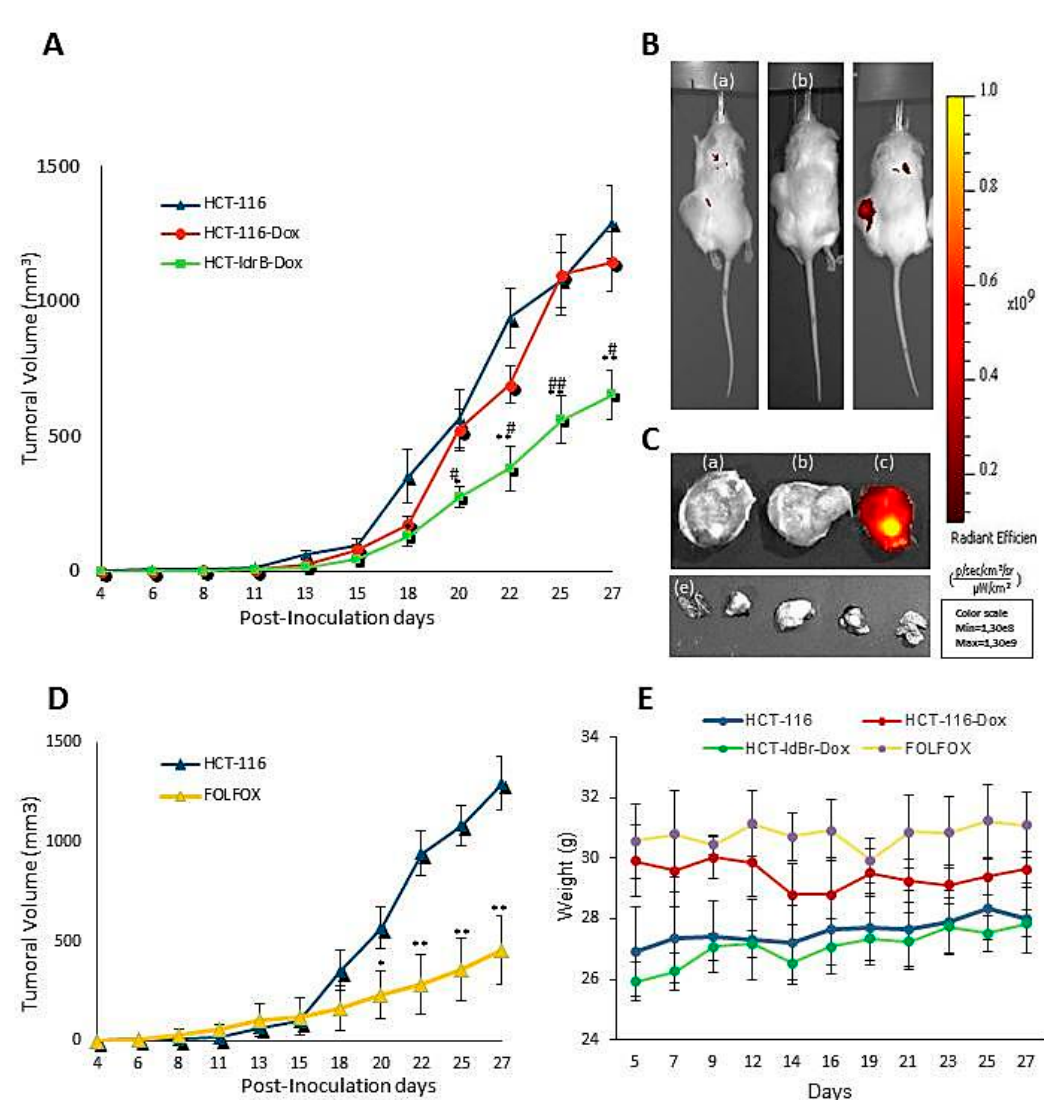
Figure 5. ldrB gene expression in HCT-116 cells reduces tumor size in vivo. ( A ) Growth rates of HCT-ldrB tumor xenografts in SCID mice (bars indicate standard deviation of tumor volumes, n = 8 sites injected, * p < 0.05, ** p < 0.01 HCT-116 and HCT-ldrB-Dox; # p < 0.05, ## p < 0.01 HCT-116-Dox and HCT-ldrB-Dox). ( B ) In vivo imaging of tumor-bearing mice (a) HCT-116, (b) HCT-116-dox, and (c) HCT-ldrB-Dox. ( C ) Representative images of fluorescent signal of (a) HCT-116, (b) HCT-116-dox, and (c) HCT-ldrB-Dox resected tumors. (e) Images of mouse organs treated with the ldrB gene (HCT-ldrB-Dox) free of metastasis. All images were captured by an IVIS Lumina Imaging System after 27 d of treatment. ( D ) Growth rates of tumor xenografts treated by FOLFOX in SCID mice (bars indicate standard deviation of tumor volumes, n = 8 sites injected), and ( E ) changes in the body weights of HCT-116, HCT-116-Dox, HCT-ldrB-Dox, and FOLFOX groups of mice during the treatment period.